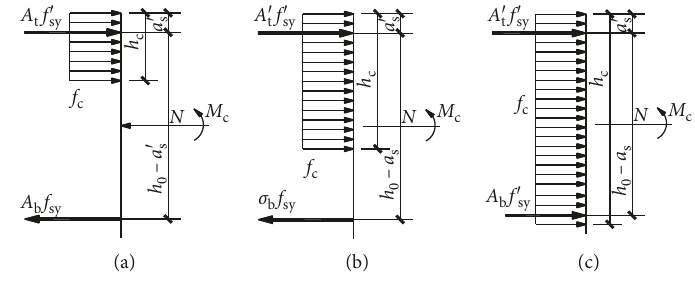
Figure 21: Diagrams for the calculation of M